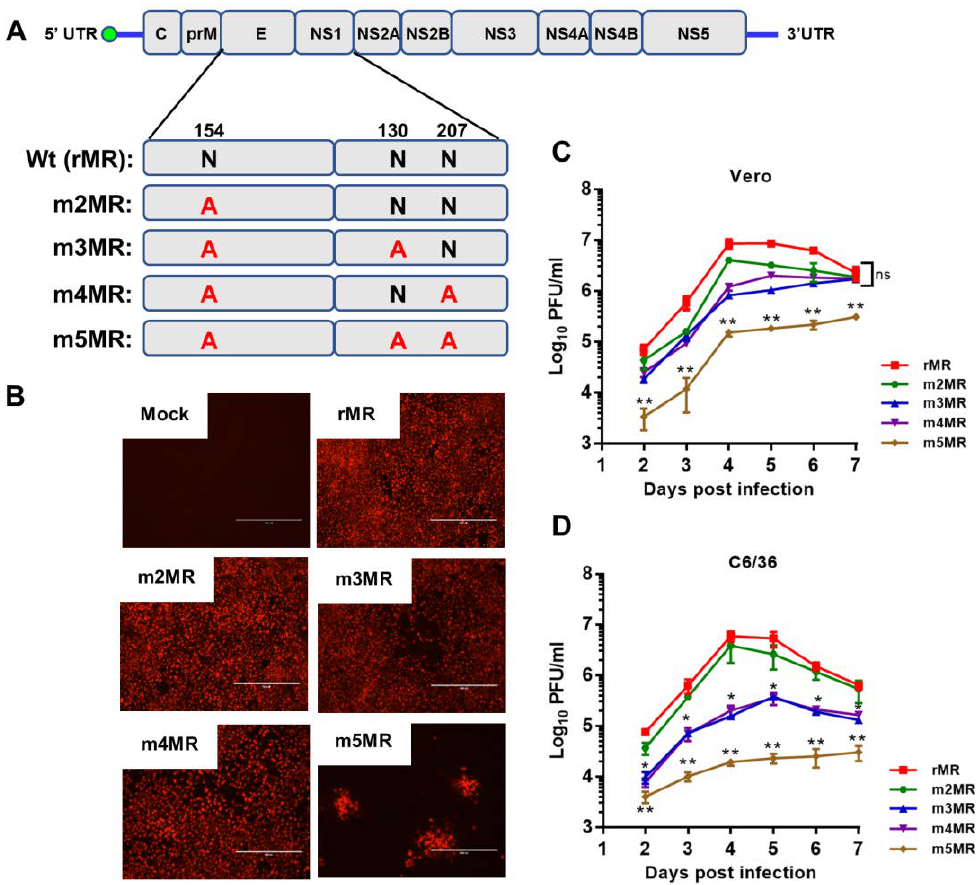
Figure 1. Characterization of the envelope (E) / non-structural protein 1 (NS1) glycosylation mutant viruses. ( A ) The ZIKV (Zika virus) genome and the encoded polyprotein, showing glycosylation sites in E (N154) and NS1 (N130 and N207). The asparagine residue at each of these sites was mutated to an alanine residue. ( B ) Two micrograms of in vitro transcribed RNA, from each of the mutant clones or the wt(rMR) clone, were transfected into Vero cells in 6-well plates. After 5 days, the transfected cells were processed for immunofluorescence staining using 4G2 monoclonal antibody to detect the E protein. Scale bar: 400 µ m. Multistep growth of rMR, m2MR, m3MR, m4MR, and m5MR viruses in Vero ( C ) and C6 / 36 ( D ) cells. The data show mean values with error bars representing standard deviation from three independent experiments. Mann–Whitney test and Kruskal–Wallis test were used to determine significance between m2MR and other mutant viruses at different times post-infection. **, p < 0.01; *, p < 0.05; ns, non-significant.